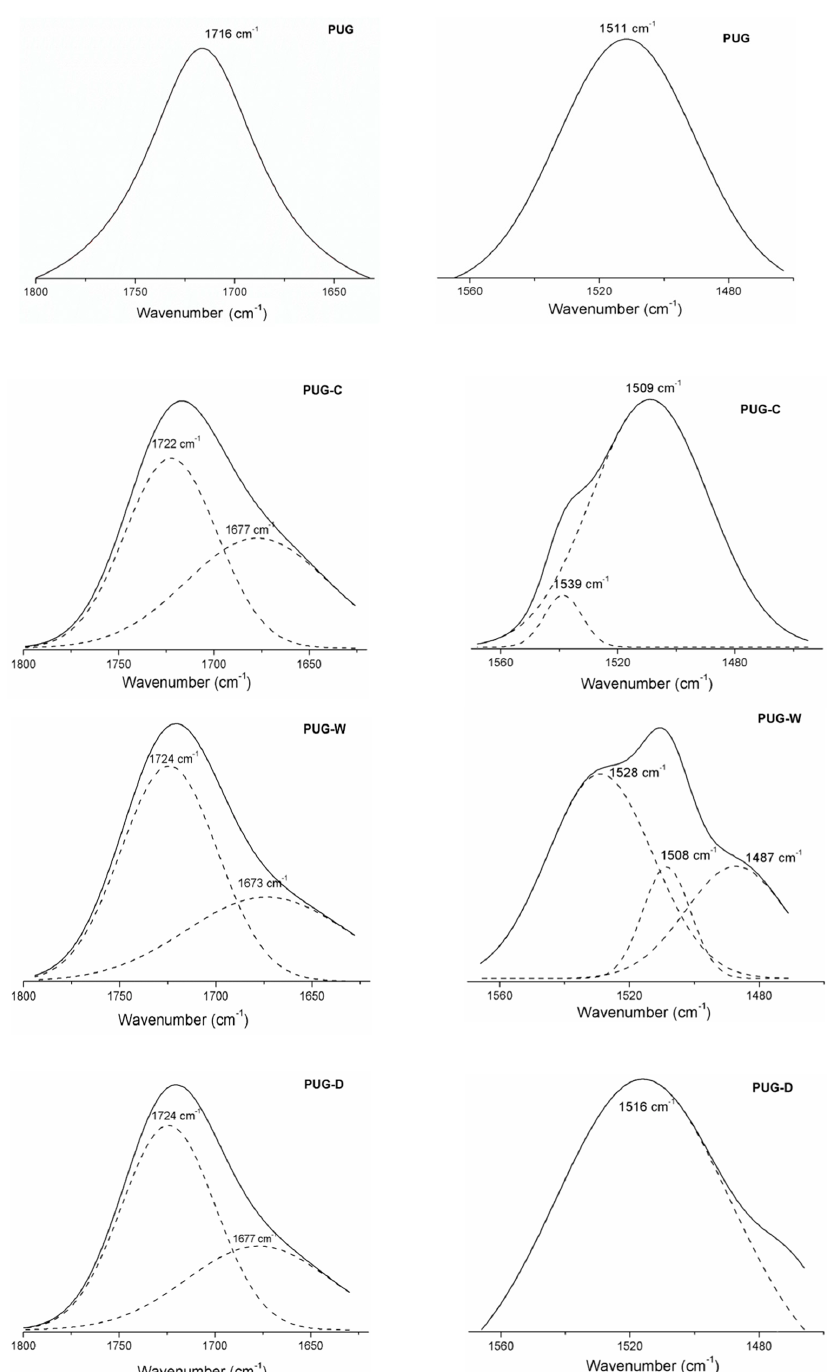
Figure 3. Deconvoluted spectra of produced foams.